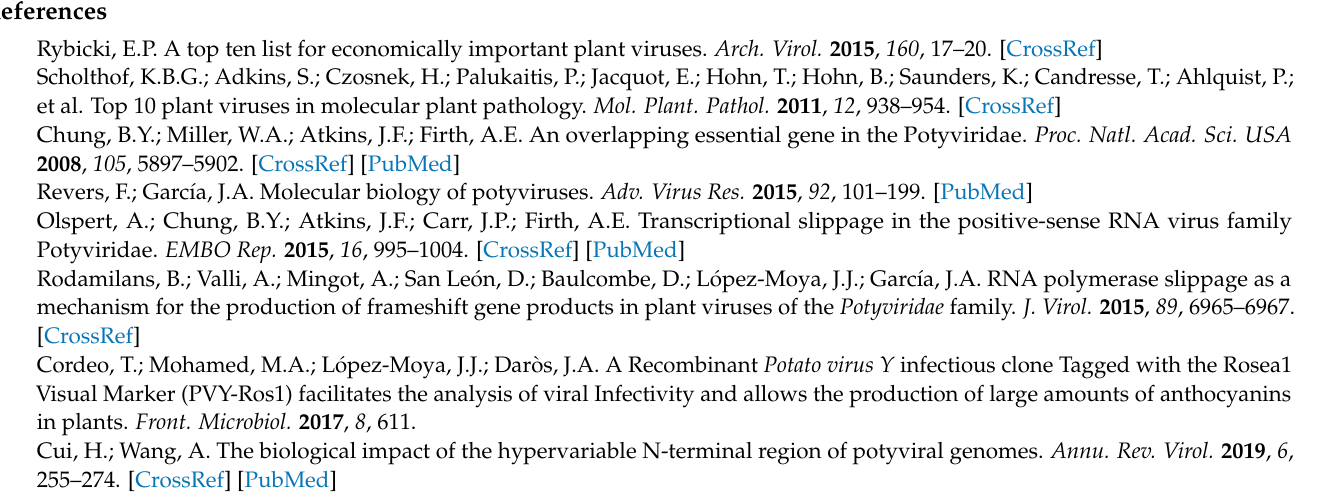
interactions. Table S1: Quantification of preferential double-immunogold localization of PVY-NIb and HSC70 in 2 × 2 contingency table from GraphPad